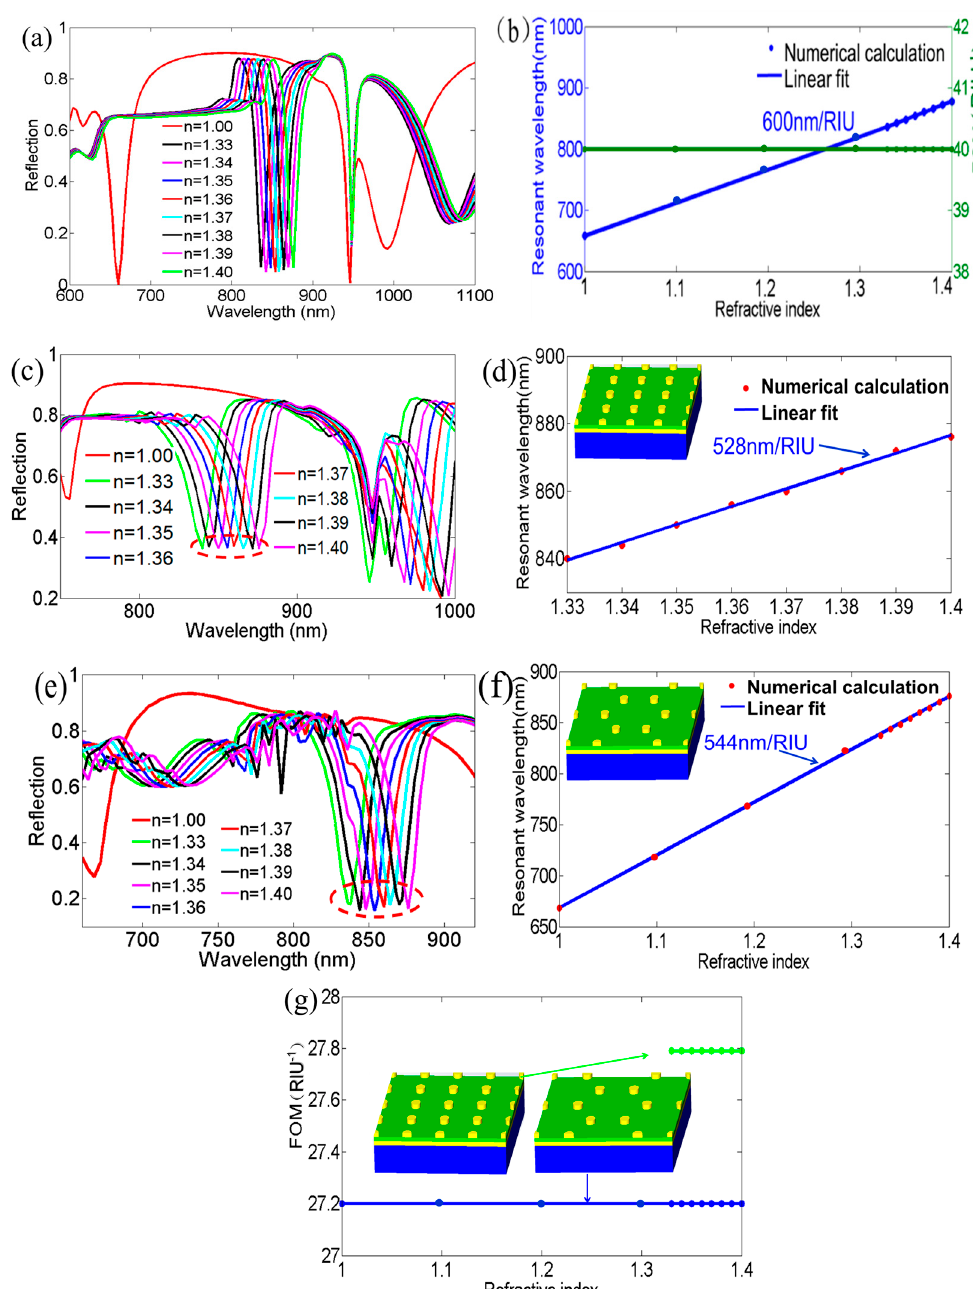
Figure 2. Investigation of the sensing performance of the discussed structure. ( a ) Reflection spectra of the layered structure with different refractive indexes (RIs); ( b ) linear response of the resonant wavelength (blue line) and the figure of merit (green line) at the first plasmon resonance for the designed layered structure. Reflection spectra corresponding to ( c ) the square nanostructure and ( e ) the honeycomb-like nanostructure at various RIs. Responses of resonant wavelengths on different RIs for ( d ) the square nanodisk array and ( f ) the honeycomb-like nanodisk array; ( g ) comparison of the figure of merits with various RIs for the square nanodisk array and the honeycomb-like nanodisk array.